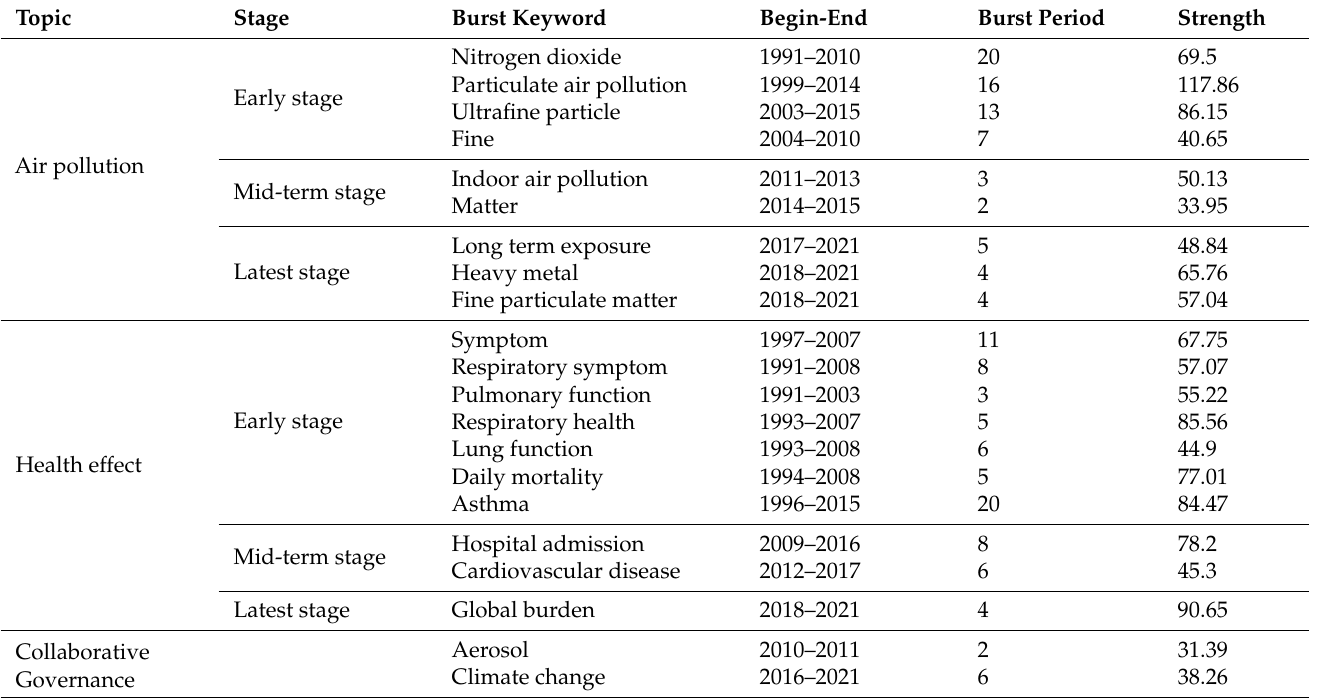
Table 4. Evolution of research frontiers in English